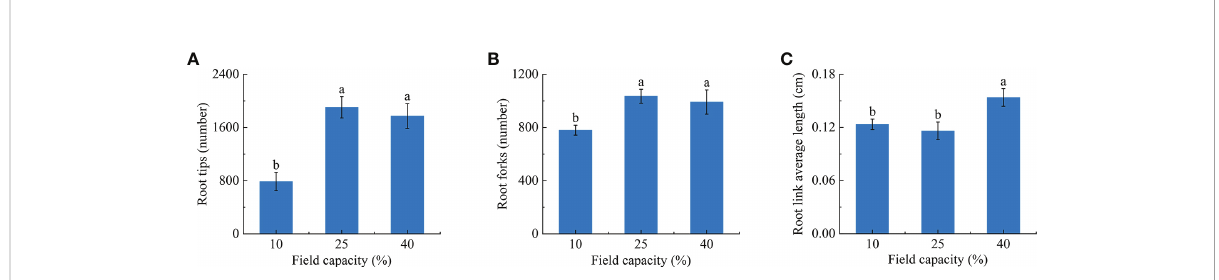
FIGURE 3 Effects of different soil moisture on root tips (A) , root forks (B) , root link average length (C) of K hirsuta. Results were analyzed by one-way ANOVA and tested for signi fi cance of difference by Duncan multiple-range method. Each value represents the mean ± standard error. Each